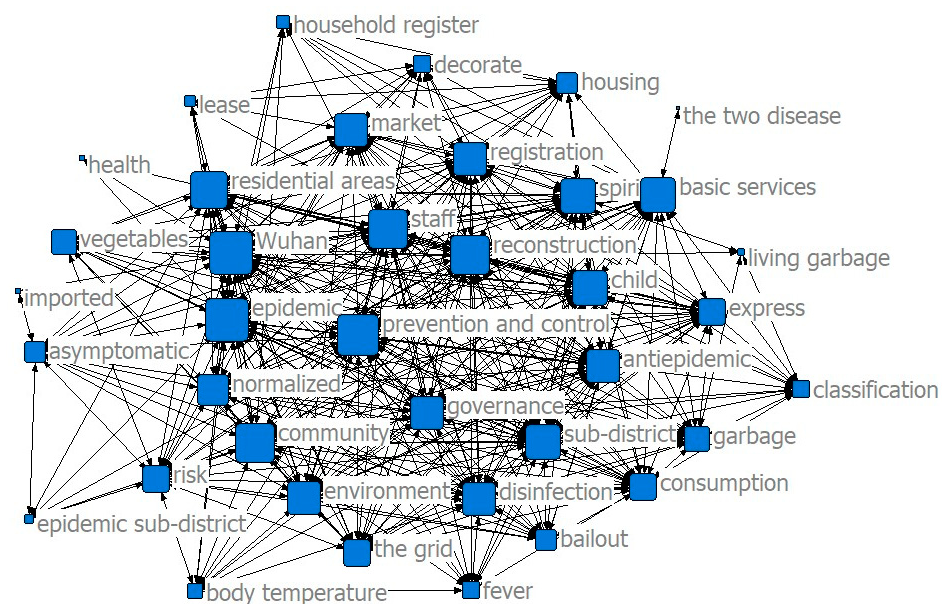
Figure 3. Community services in the low-incidence period.